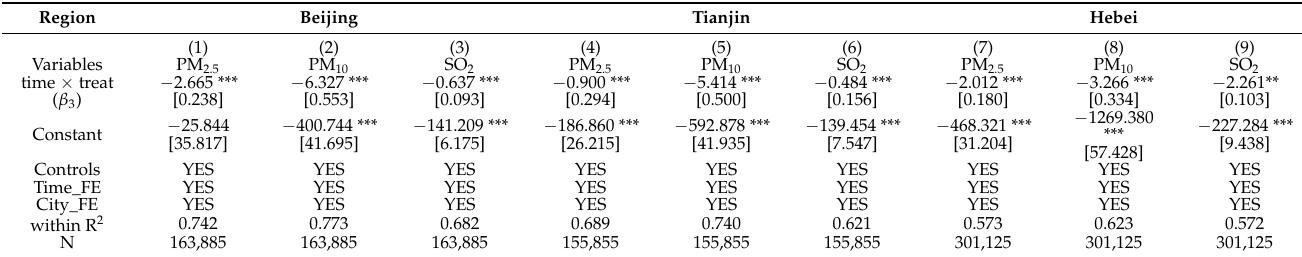
Table A3. Estimation results of the BSDW policy on different regions.